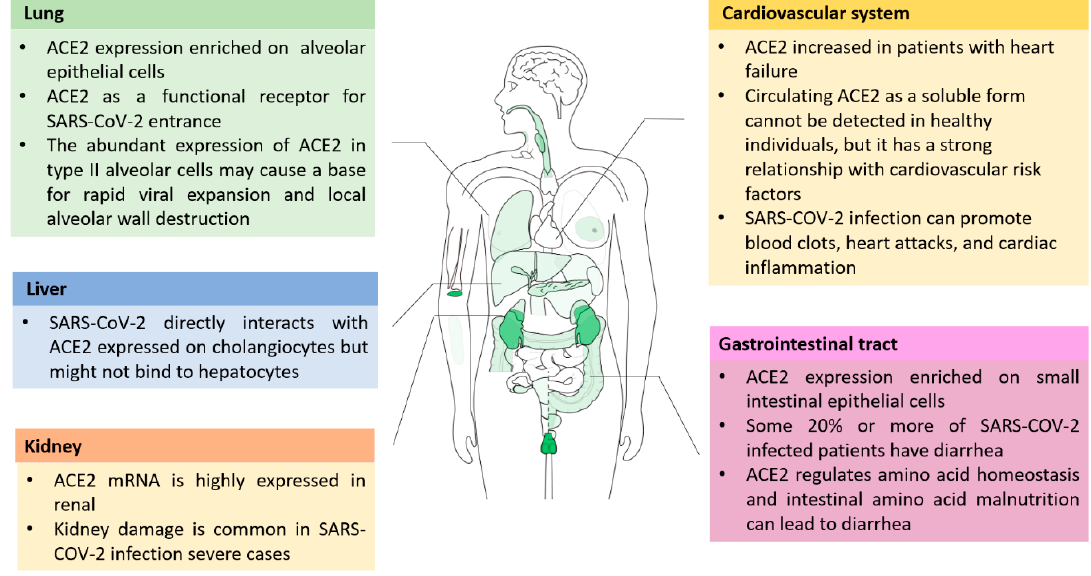
Figure 2. ACE2 tissue distribution and its potential association with severe acute respiratory syndrome coronavirus 2 (SARS-CoV-2) infection sites and disease pathology. ACE2 is mainly localized on endothelial cells and can be found in tissues, and among them kidneys, testis, and gastrointestinal tract, and have the highest ACE2 expressions. SARS-CoV-2 mainly spread via the respiratory tract, and type I and type II alveolar cells are the important sites of entrance for SARS-CoV-2, in particular, the abundant expression of ACE2 in type II pneumocytes may cause rapid viral expansion and local alveolar wall damage, resulting in further severe diffuse alveolar destruction. Except for the lungs, SARS-CoV-2 infection also can extend to many organs, including the heart and blood vessels, kidney, liver, and gut.